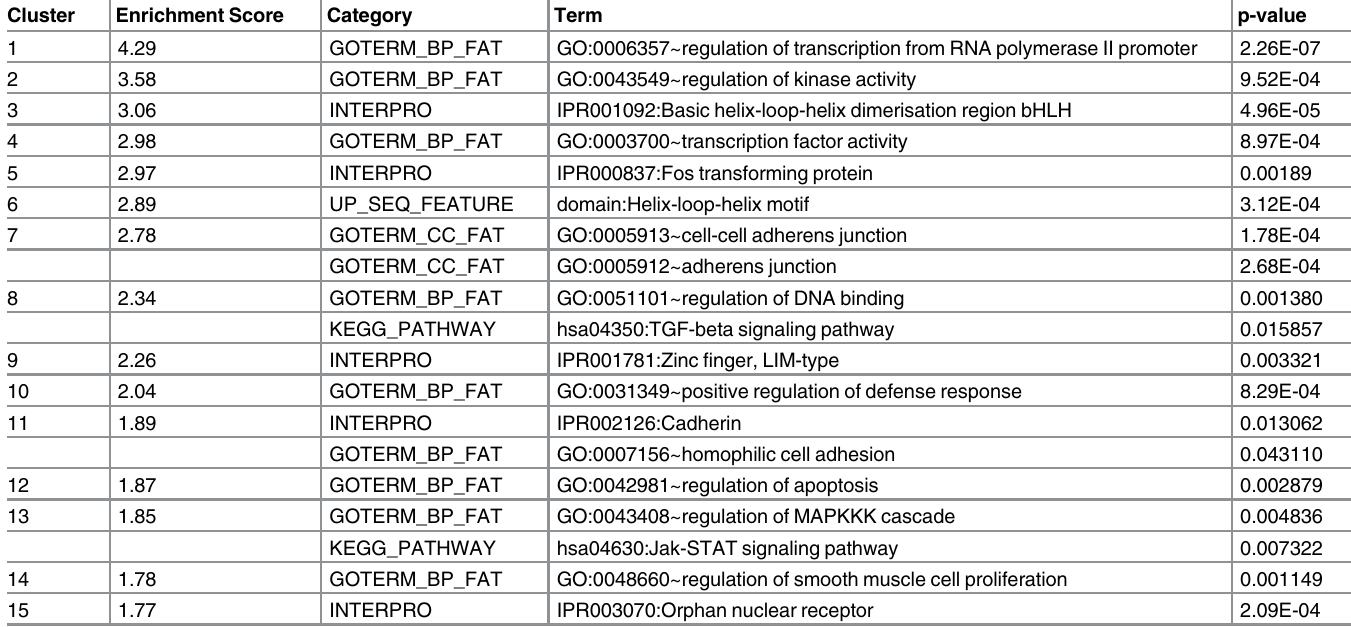
Table 4. Selection of DAVID functional annotation clustering of down-regulated genes.